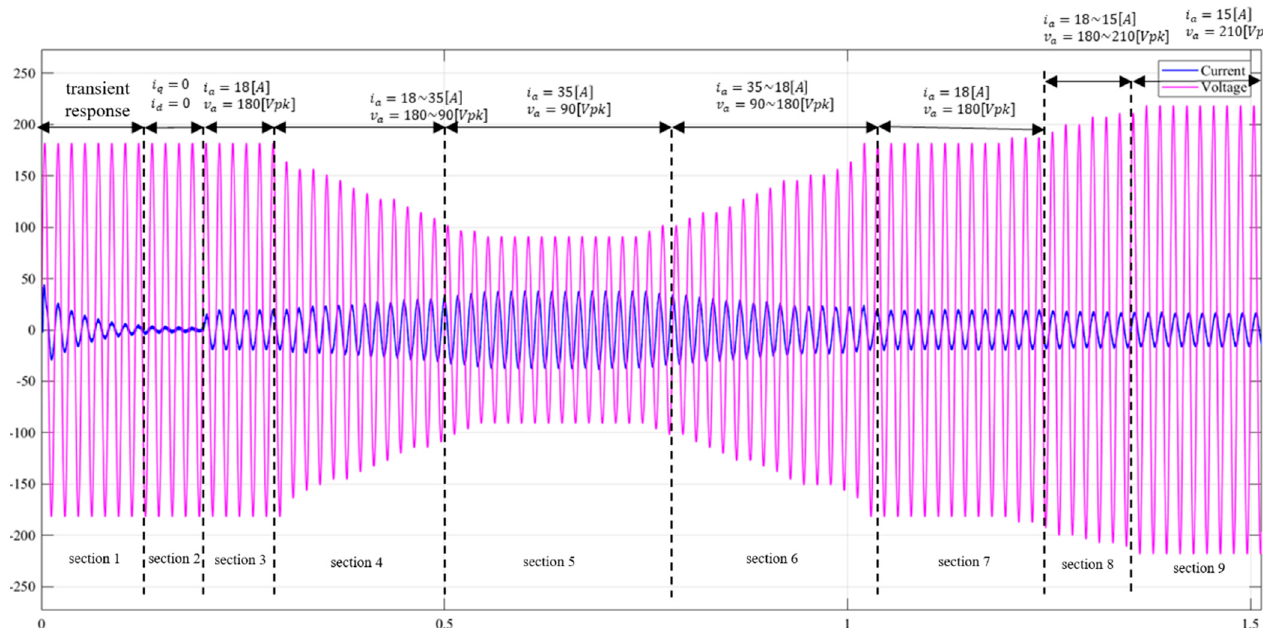
Figure 17. Overall graph of varying grid voltage and current.